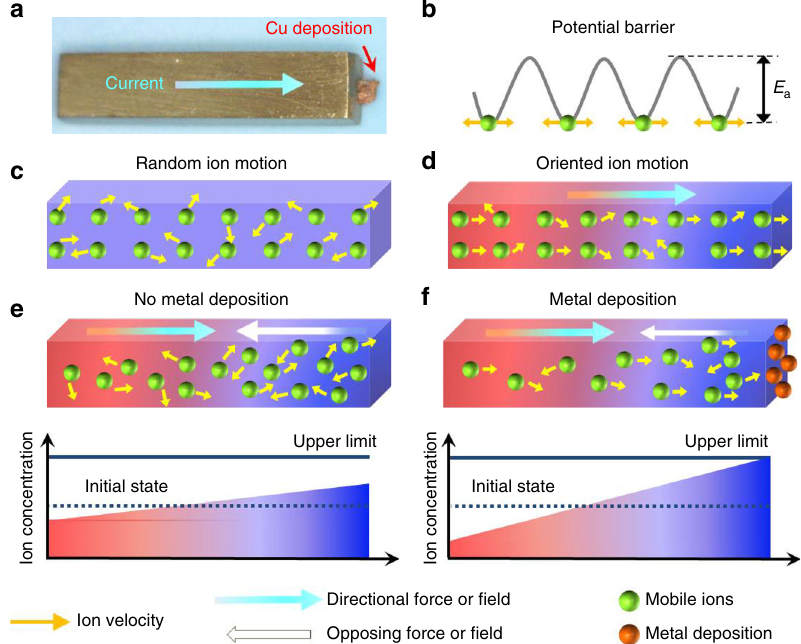
Fig. 1 Atom migration and deposition in ion conductors. a Metallic Cu deposition on the surface of a Cu 2 S sample induced by a current. b – e Schematic of ( b ) the energy landscape for ions; c random ion motion without net fl ux; and d net ion fl ux under directional force or fi eld. Due to a directional force or fi eld and depending on the electrode constraints, MIECs may either reach a ( e ) steady state without net ion transport (and without metal deposition) or ( f ) continuous metal deposition (or other decomposition), if the local Cu concentration reaches a critical level determined by the stability range of